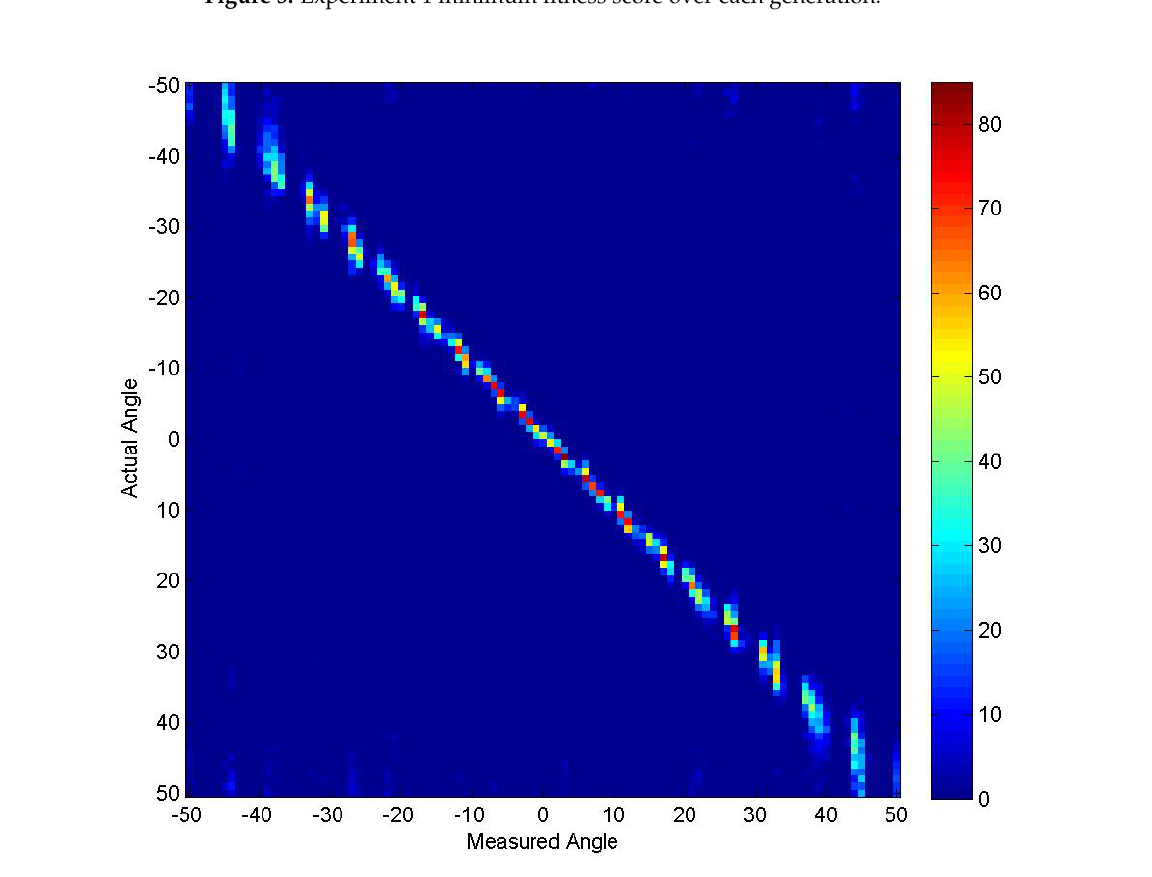
Figure 5. Experiment 1 minimum fitness score over each generation.